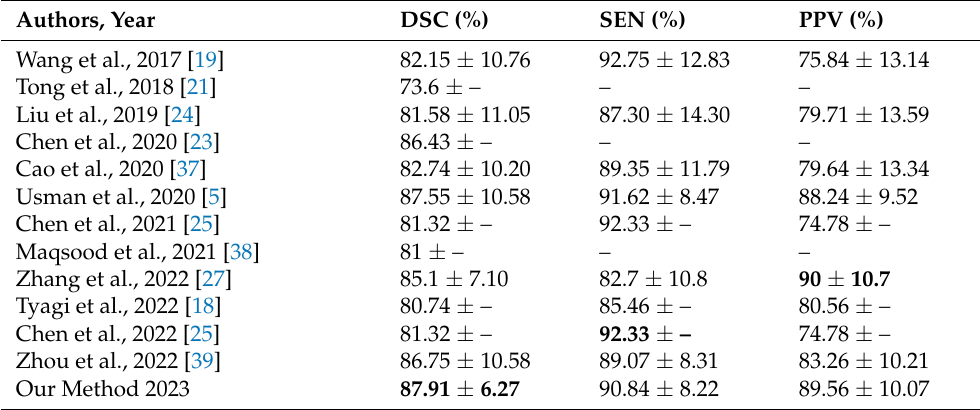
Table 1. The quantitative results of our proposed scheme along with previously published studies in terms of mean ± standard deviation of all quantitative measures used in this study. The best performance is indicated in bold, and – indicates the absence of value.